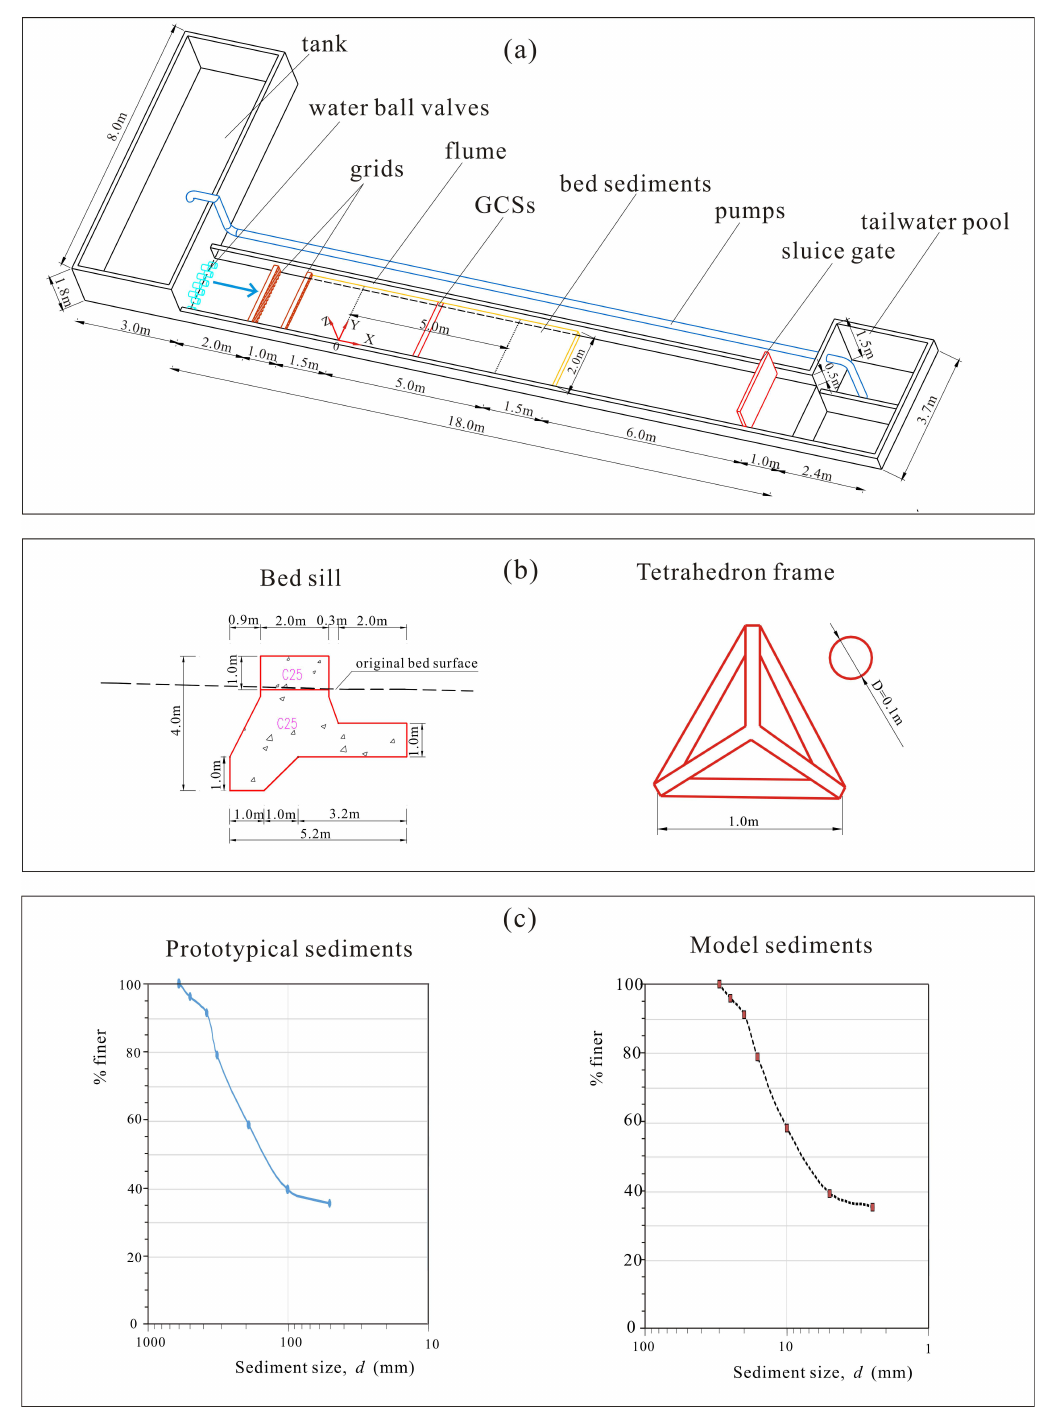
Figure 4. Experimental design: ( a ) diagrammatic sketch of the experimental installation; ( b ) sketches of the structures including a bed sill and a tetrahedron frame; and ( c ) particle-size distribution curves for the sediments in the natural river and used in the